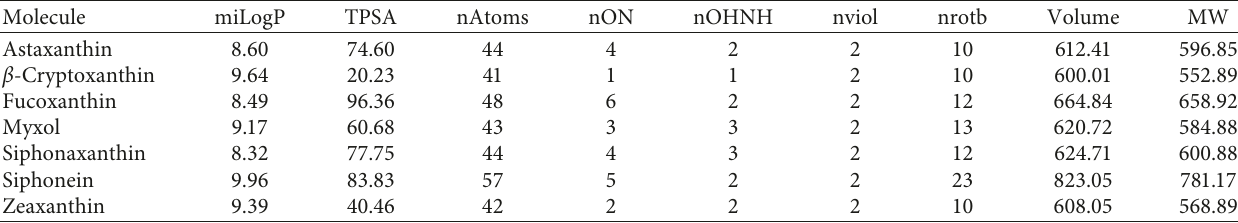
Table 14: Molecular properties of the seven carotenoid pigments calculated to verify the Lipinski’s rule of five. Molecule miLogP TPSA nAtoms